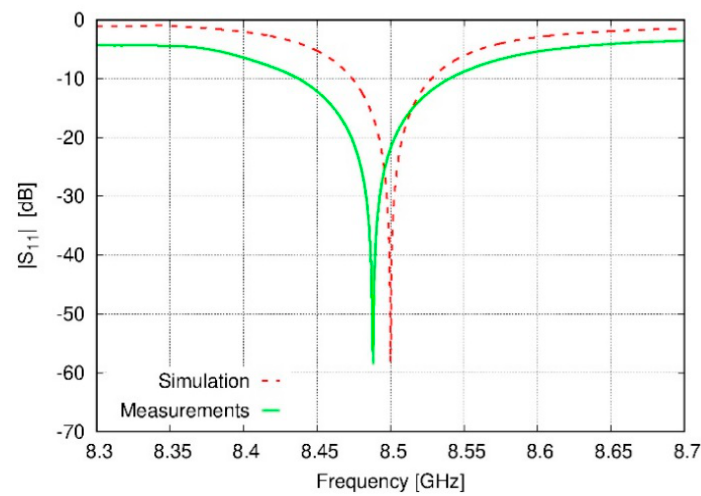
Figure 10. Comparison of S 11 curves from simulated and experimental data—the latter by using the antenna designed on specifications for solution #6 of Table 2. Table 4. Description of the prototyped antenna at 8.5 GHz. Parameters according to Figure 1A.